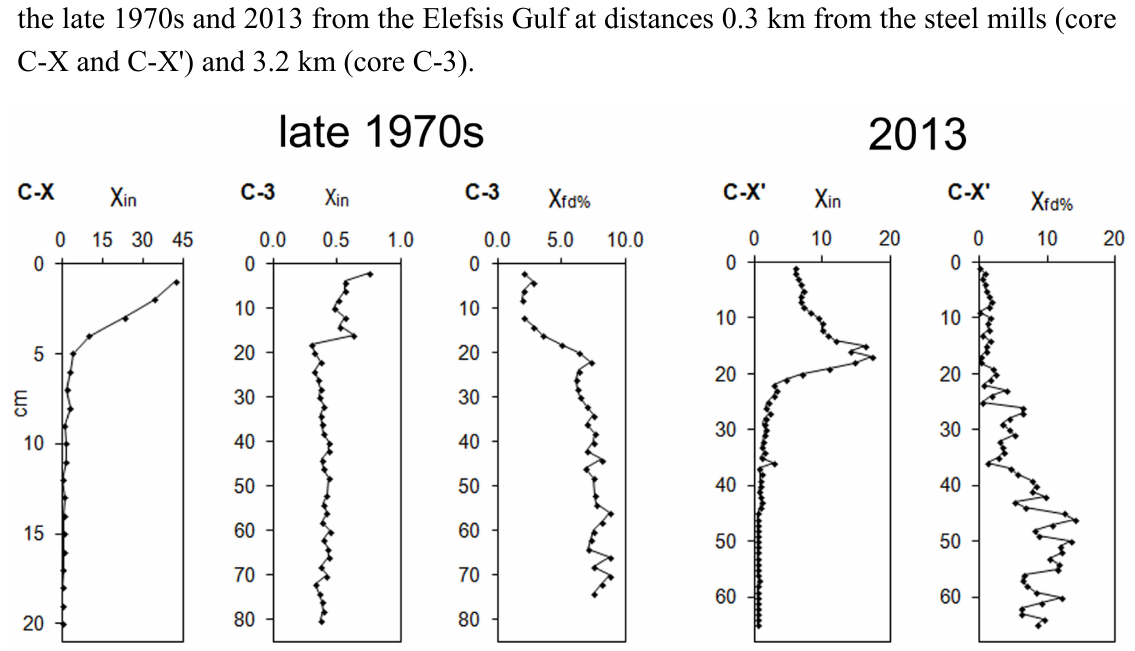
in 10 − 6 m 3 ·kg − 1 ) and frequency in ) as a percentage of χ in cored sediments sampled in fd in